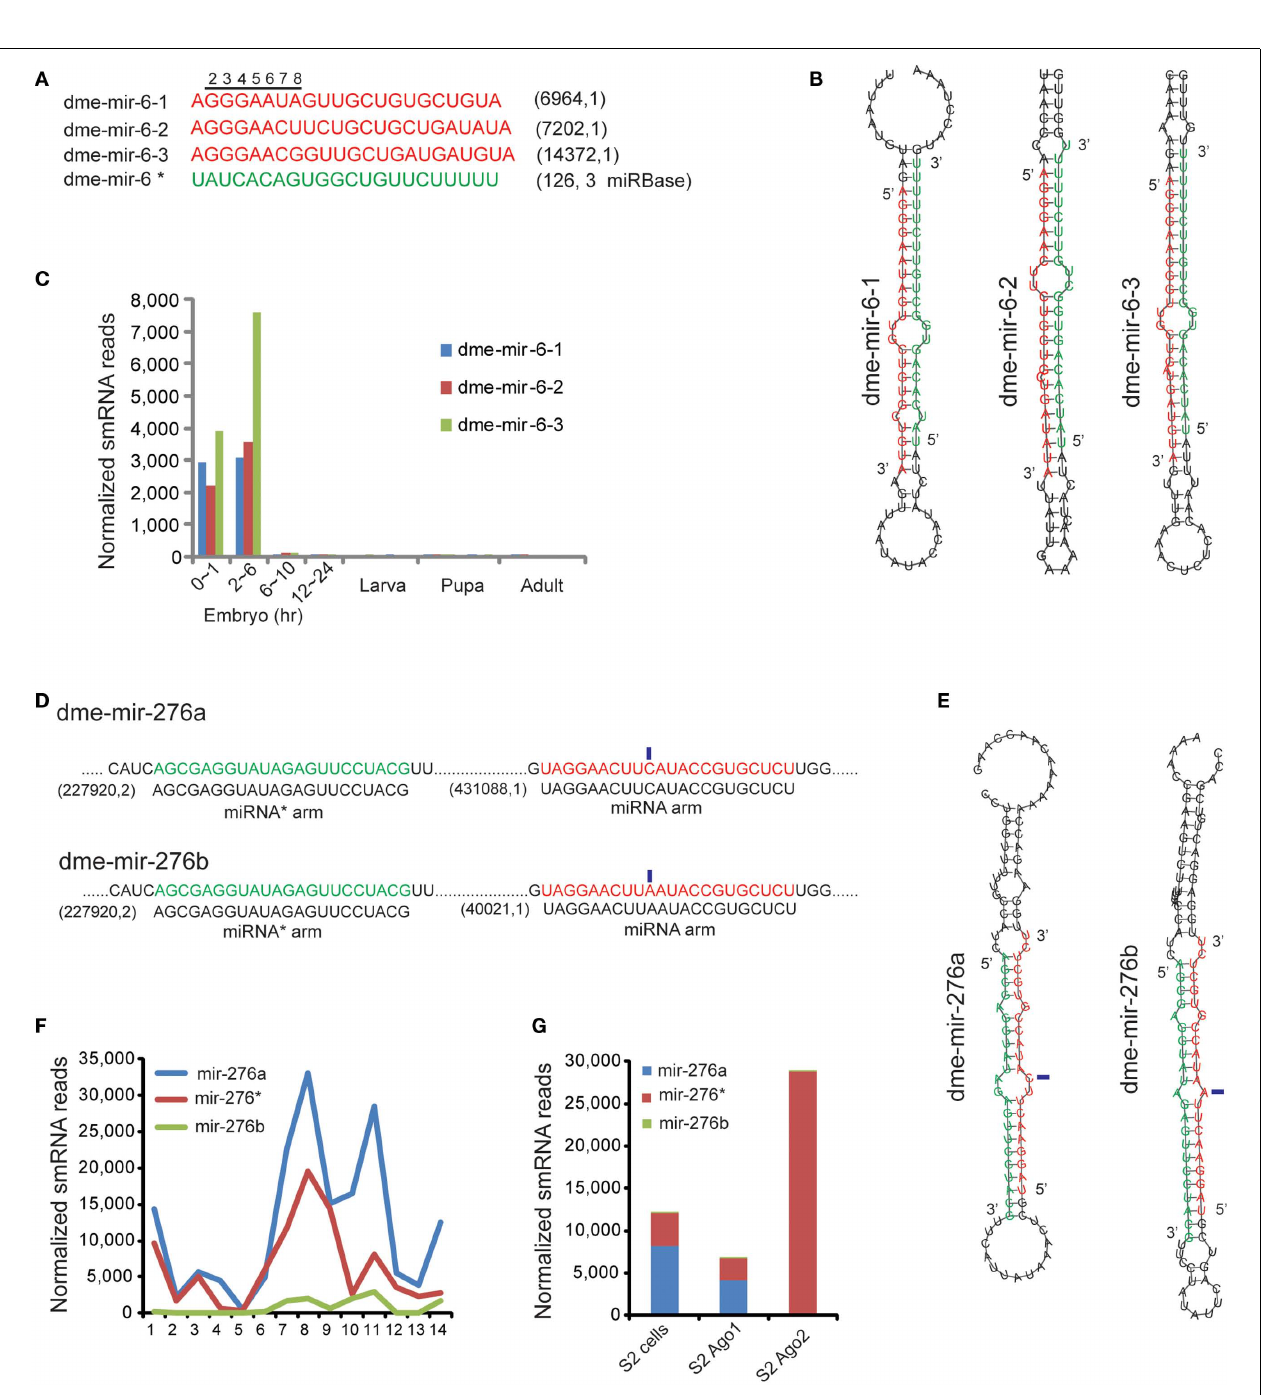
FIGURE 4 | Correction of miR-6 family demonstrates the mis-annotated miRNA and miRNA ∗ strands. (A) The corrected D. melanogaster miR-6 family sequences (red).The miRBase annotated miR-6 mature sequence is actually the miRNA ∗ sequence (green).The corrected miR-6 members have distinct 5 (cid:2) seed sequences differing at seventh and eighth nucleotides. (B) The hairpin structures of the three members of dme-miR-6 family show the miRNA ∗ strands are conserved. (C) The expression profile rebuilt based on